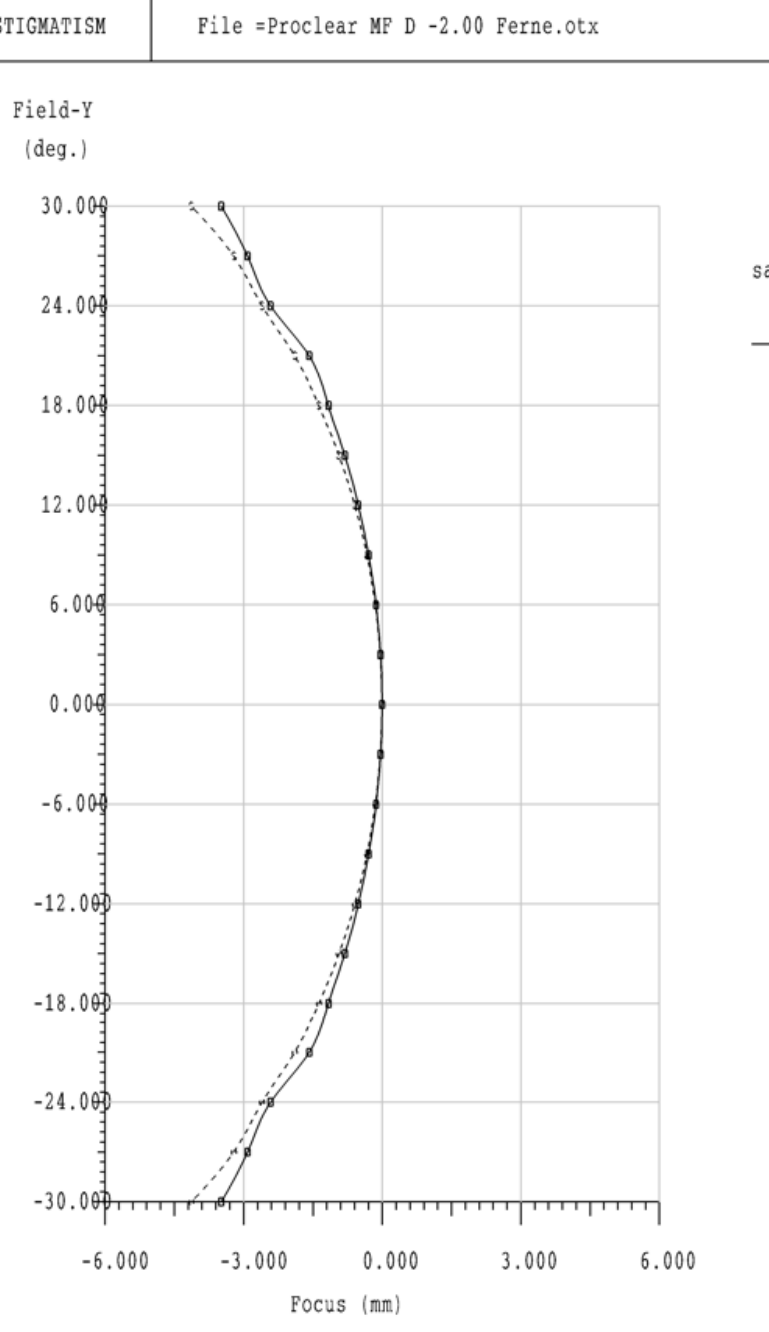
Figure 6. Peripheral refraction with Proclear multifocal correction − 2.00 D of myopia, viewing distance at infinity: sagittal and tangential focal lines. Within the central 12° is a plano-refraction; after the central 12° both focal lines become myopic relative to the center (Fovea).